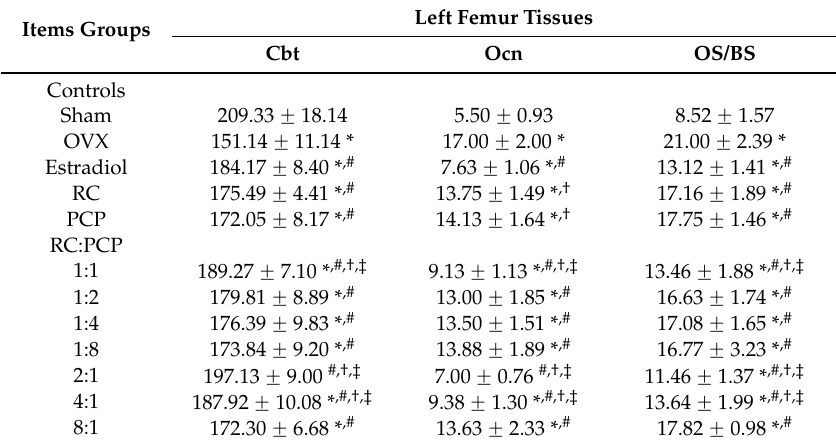
Table 8. Histopathology-Histomorphometry for the femur in sham-operated or OVX ddY mice: cortical bones and osteoclast